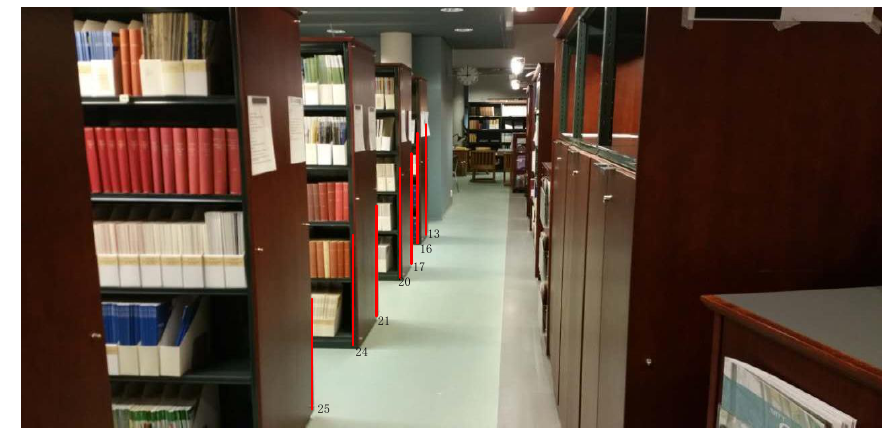
Figure 4. The FGI open style library environment and a part of selected feature points.